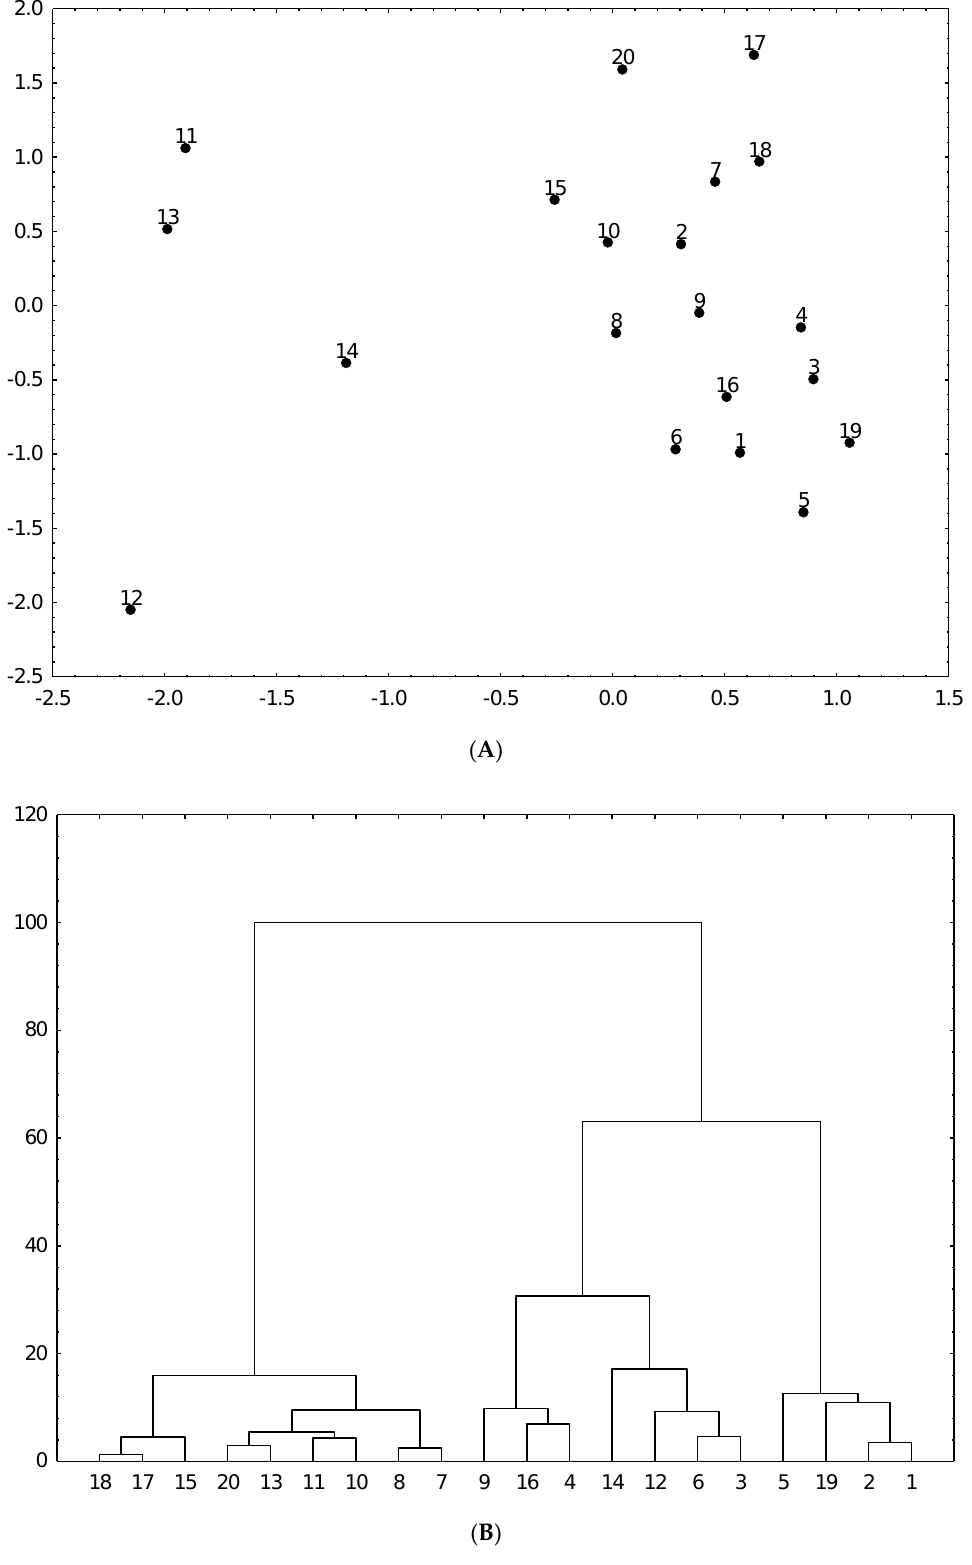
Figure 1. Principal component analysis scatterplot ( A ) and cluster analysis tree diagram ( B ) for wild and commercial samples of R. canina L.